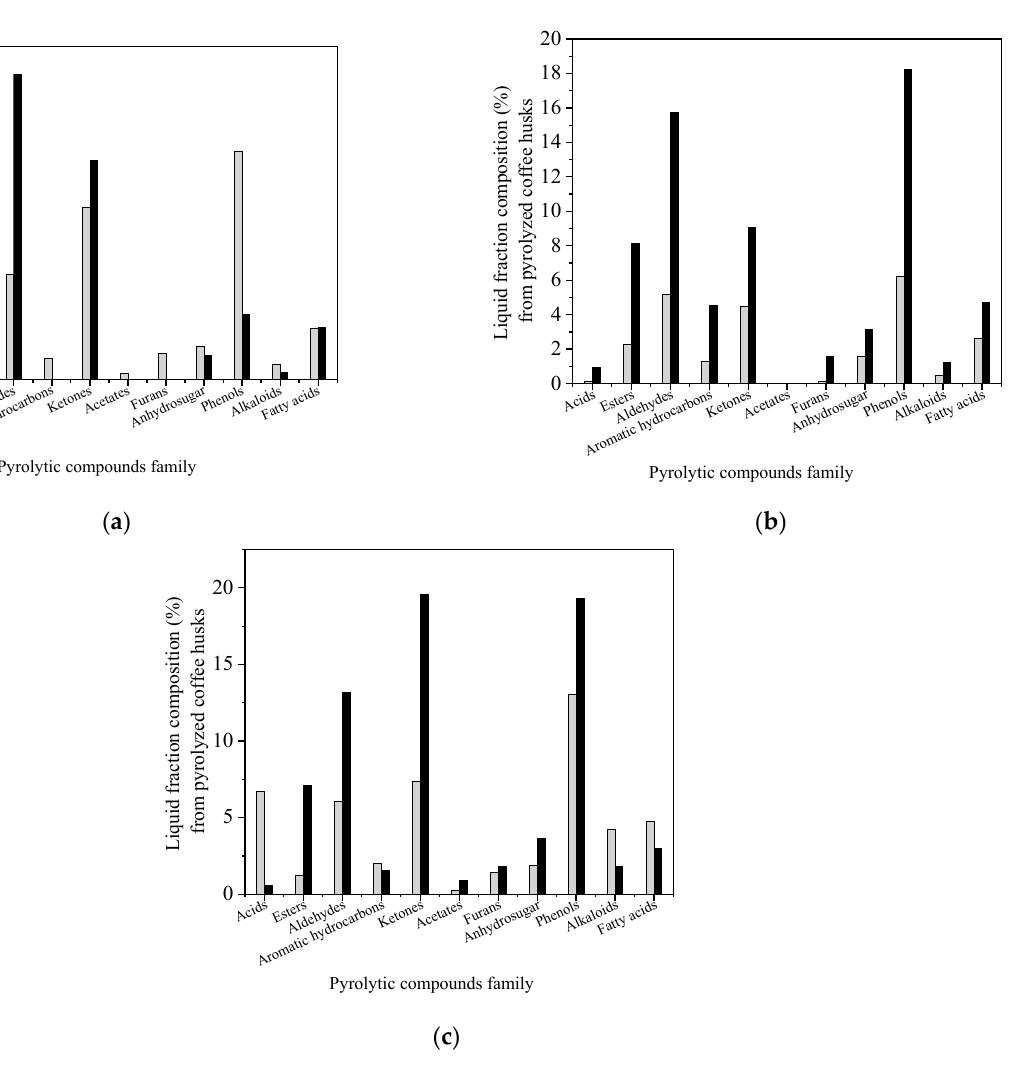
Figure 5. Pyrolytic compounds in the liquid fraction obtained from untreated and HNO 3 (0.1 wt%)/H2 S O 4 (0.1 wt%) washed coffee husks after fast pyrolysis at: ( a ) 400 °C; ( b ) 500 °C; ( c ) 600 °C. Symbols: untreated biomass; treated biomass.